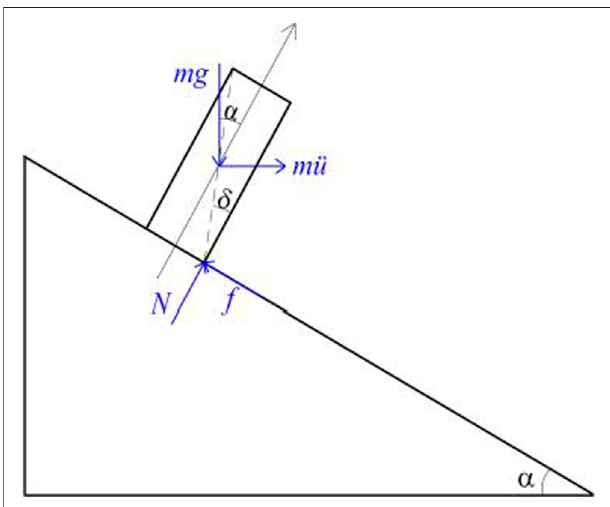
FIGURE 3 | 2-D schematic representation of veri fi cation model.